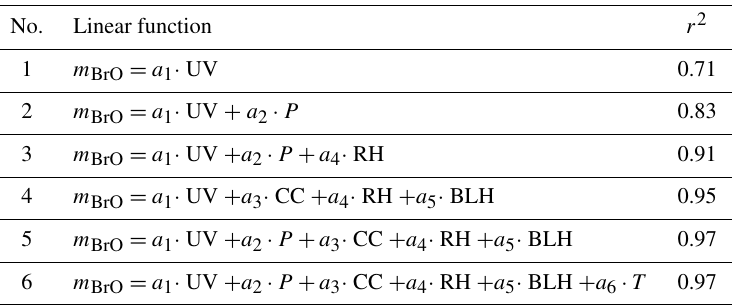
Table 2. Best fits from the multilinear regression analysis in order to model the seasonal BrO mass variation over the Rann of Kutch in dependency of UV surface radiation (UV), precipitation ( P ), cloud coverage (CC), relative humidity (RH), boundary layer height (BLH) and surface temperature ( T ).